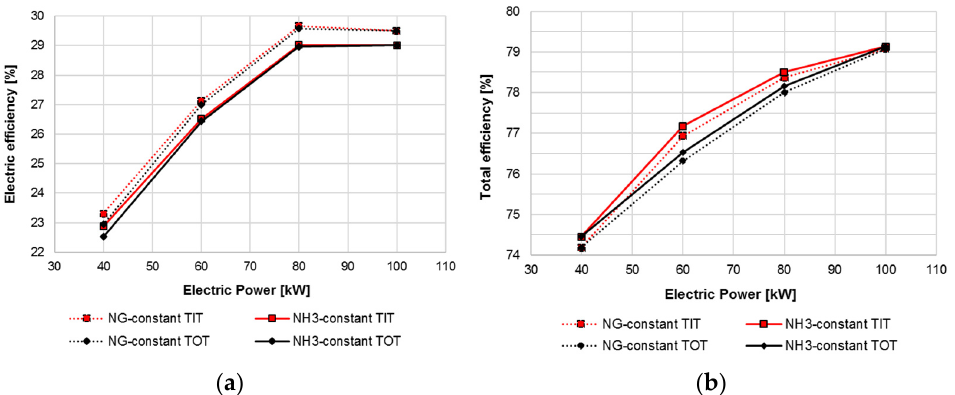
Figure 11. Effects of replacing NG with NH 3 , by varying part ‐ load control strategy, on: (a) electric efficiency; ( b ) thermal efficiency.